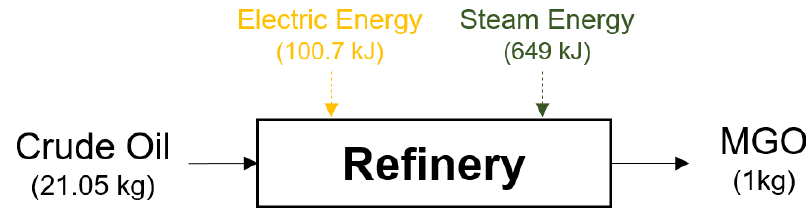
Figure 5. Modeling of the refinery process for the MGO in well-to-tank phase. Natural gas is produced and processed in LNG-producing countries, i.e., Qatar, Aus- tralia, Oman, and others, in consideration of the proportion of the LNG import of ROK, as shown in Figure 4b. The processing step is to remove the undesired components, e.g., CO 2 , water, and H 2 S, at the extraction site before being transported to the LNG terminal. After being transported, the natural gas is liquefied in the terminal after the purification process, which includes the removal of acid gas, dehydration of the gas, the removal of mercury, and the recovery of the LPG in the natural gas [31]. The LNG is moved to Yeosu in ROK by an LNG carrier that is equipped with the X-DF engine, as shown in Table 1, and it is bunkered to a ship through the LNG bunkering process as modeled in Figure 6, considering the electric energy input (4.46 kJ for 1 kg of LNG) and the loss of methane during the bunkering process [31].